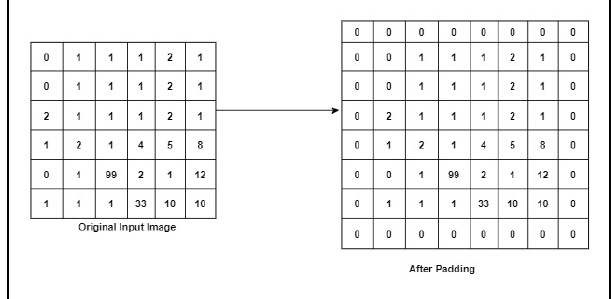
Figure 4. The Padding Example.